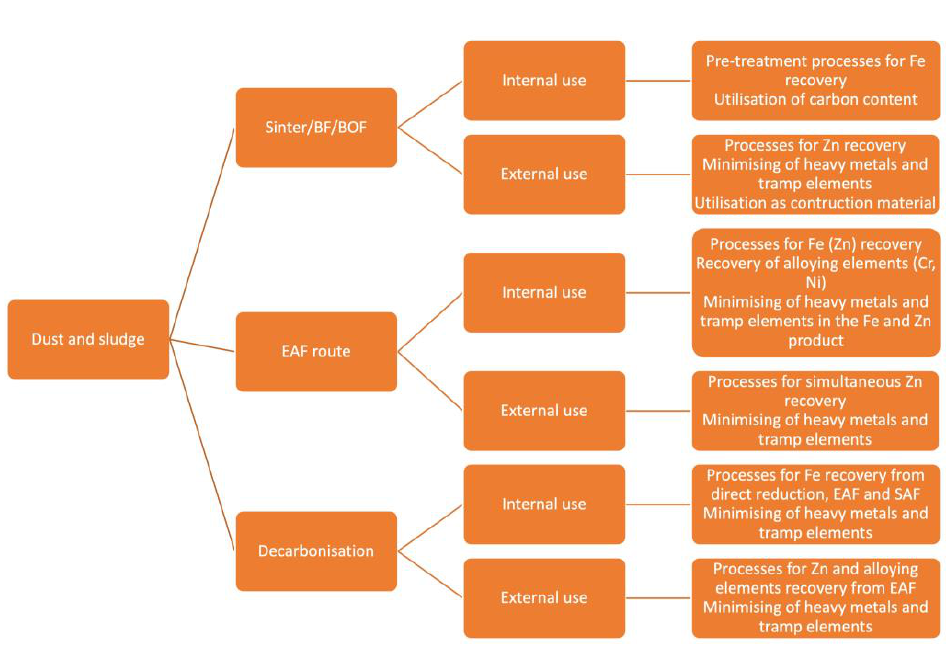
Figure 10. Future research needs on dust and sludge.